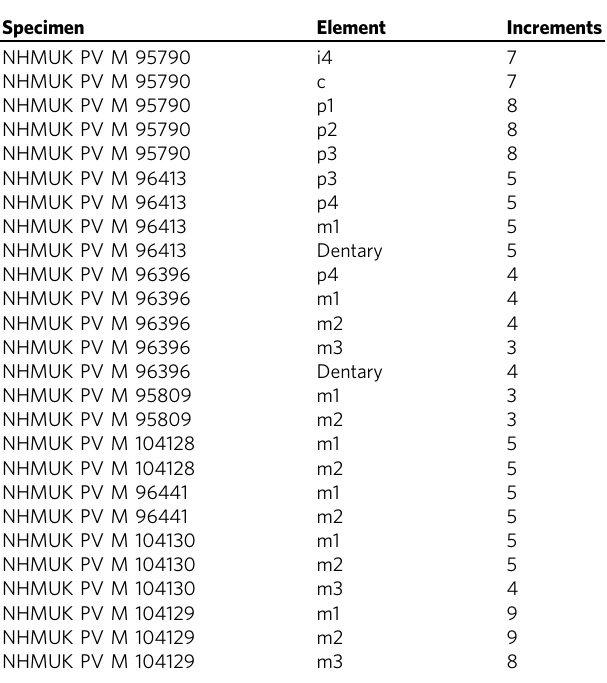
Table 1 Cementum and dentary increment counts for each element of dentulous Morganucodon